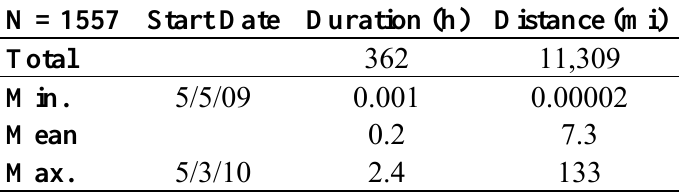
Table 3. Driving behavior